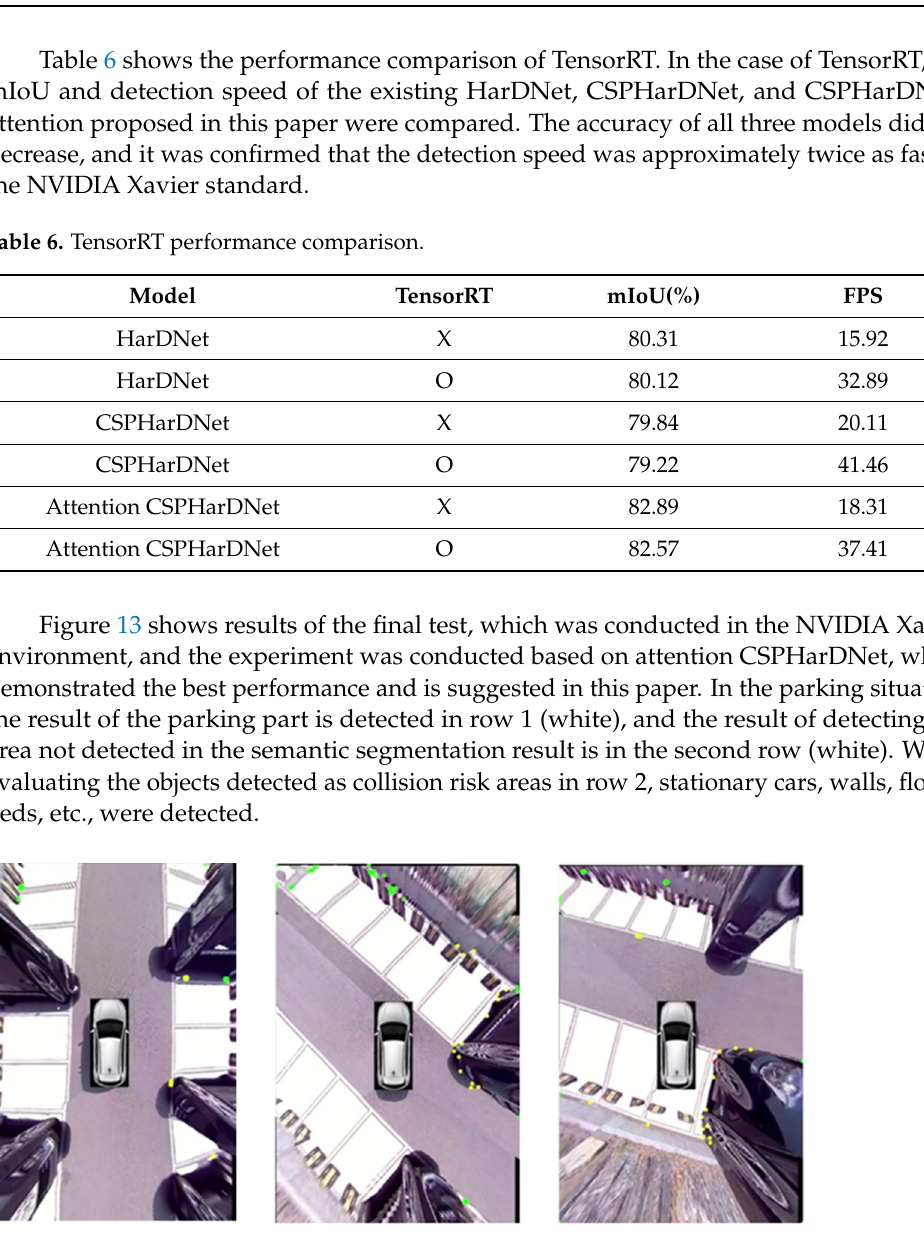
Figure 13. NVIDIA Xavier detection results. 6. Conclusions In this paper, research was conducted in order to detect parking areas and collision risk areas based on deep learning using a camera sensor. Importantly, I created a dataset in the parking lot of Chungbuk National University in order to detect it from an AVM image. A network was constructed using the semantic segmentation algorithm, and CSP- Net and attention were added to implement an optimal algorithm that could be used with good performance in a real-world vehicle environment. Various attempts were made for the activation function, optimization technique, and loss function to find the optimal con- ditions and learning. In order to use the original images as-is, an encoder was constructed, considering the amount of computation. For optimizing the training network, we used AMP to reduce the training memory and training time and used TensorRT in order to achieve an over two-fold FPS. By converting the desktop (PC)-created model to C++, we found that it was possible to detect the parking area and the drivable area with the NVIDIA Xavier and to detect the other areas as collision risk areas in order to detect the parking area and the collision risk area in indoor and outdoor environments. For the per- formance test, the self-produced AVM image and the image received from the National Institute of Intelligent Information Society (NIA) were tested, and an actual vehicle test was conducted in the Chungbuk National University parking lot. In future work, our re- sults would be suitable in an environment similar to the currently learned data; however, the results were not obtained in new environments, e.g., parking lots with illegal parking, women-only parking lots, and parking lots for the disabled. For future work, I plan to conduct research for improving the performance. The final goal of this study is to detect collision-risk objects while parking and, to measure the exact distance between objects and vehicles, I plan to implement an algorithm to find the distance based on a model learned using a camera and LiDAR. I plan to conduct research to find the exact location of the detected object using only the camera in a real vehicle.